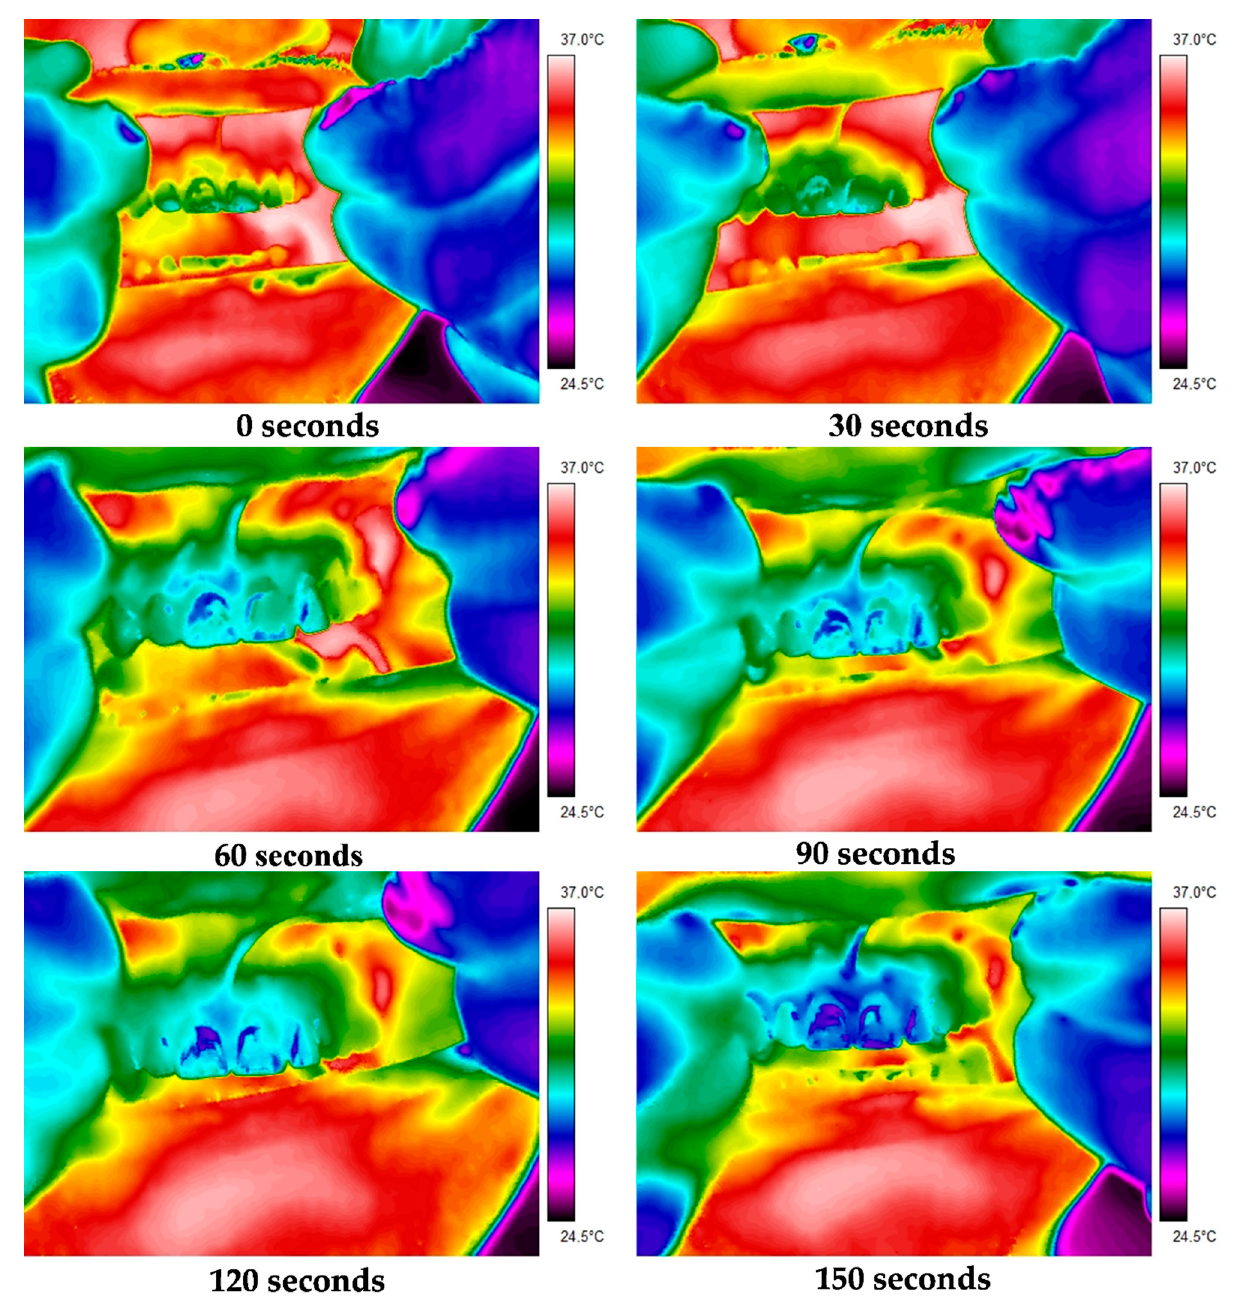
Figure 1. Thermal images of patient I: teeth 21 and 22 after endodontic treatment without periapical lesions; contralateral healthy teeth 11 and 12.